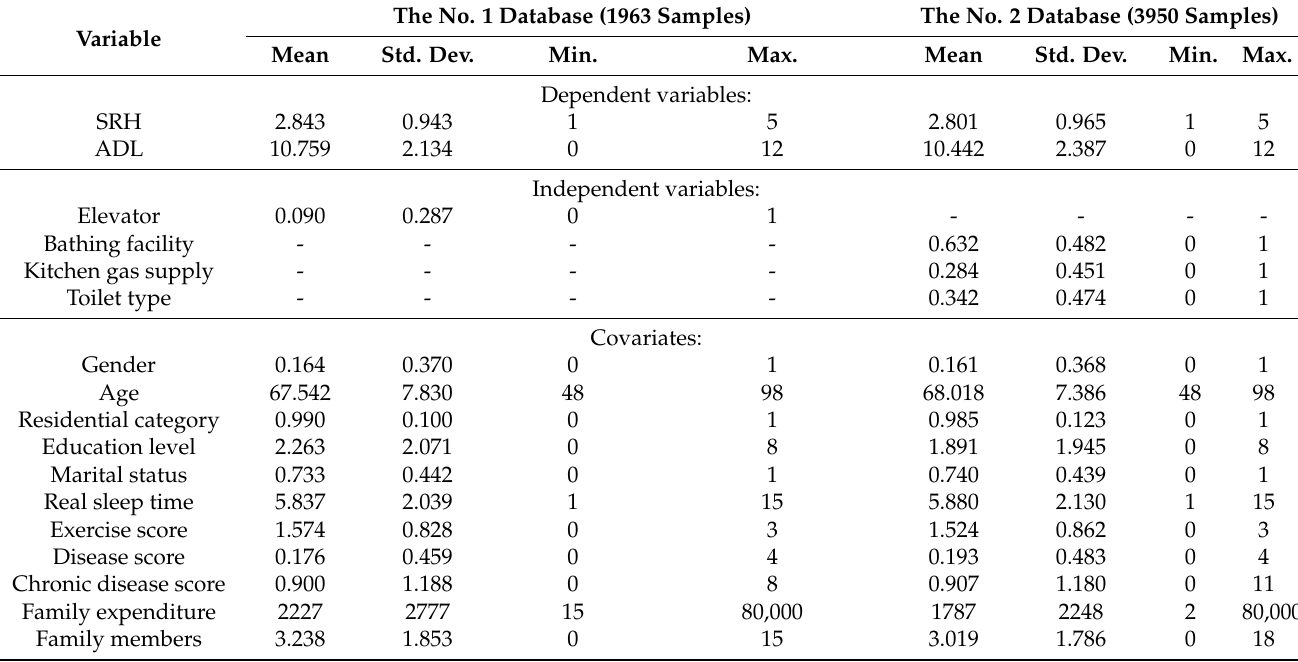
Table 2. Descriptive statistics of the